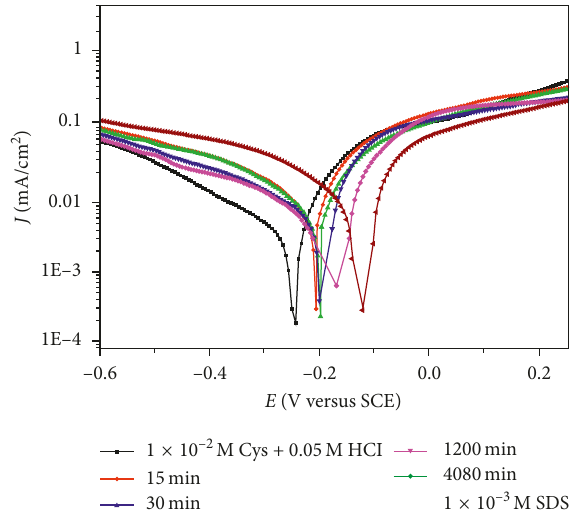
Figure 8: Polarization curves for brass in 0.05M HCl+ 1 · 10 − 2 M cysteine solution after immersion in 1 · 10 − 3 M SDS solution for various periods of time (15, 30, 60, 1200, and 4080min; scan rate, 1